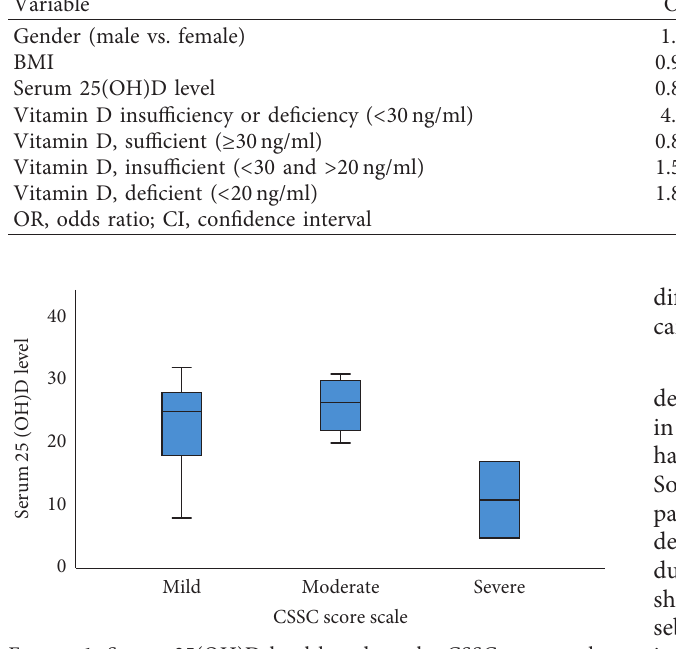
Figure 1: Serum 25(OH)D level based on the CSSC score scale. Data are shown as mean, minimum, maximum, and